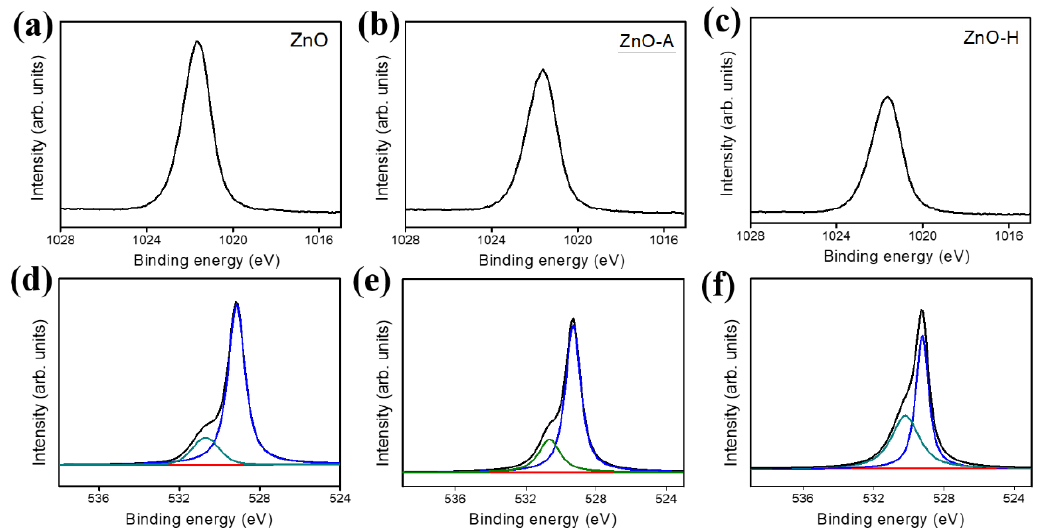
Figure 5. Zn 2p narrow scan spectra of various ZnO sheets: ( a ) ZnO. ( b ) ZnO-A. ( c ) ZnO-H. O1s narrow scan spectra of various ZnO sheets: ( d ) ZnO. ( e ) ZnO-A. ( f ) ZnO-H.